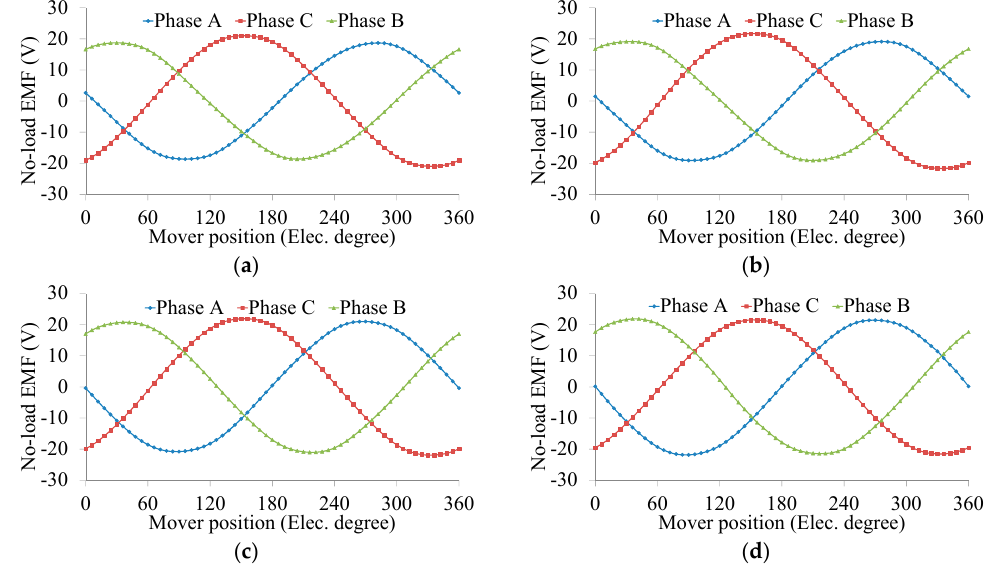
Figure 15. 3-phase no-load EMF waveforms. ( a ) Machine I; ( b ) Machine II; ( c ) Machine III; ( d ) Machine IV.